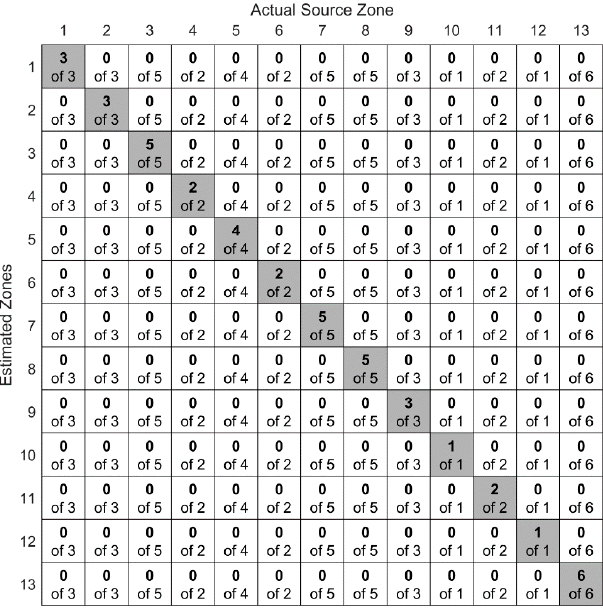
Figure 13. The confusion matrix of the stacked autoencoders in zonal localization of the second experimental scenario.